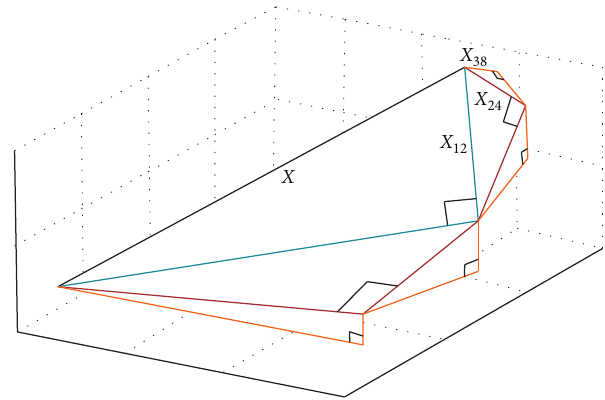
Figure 3: The geometry structure of Deep